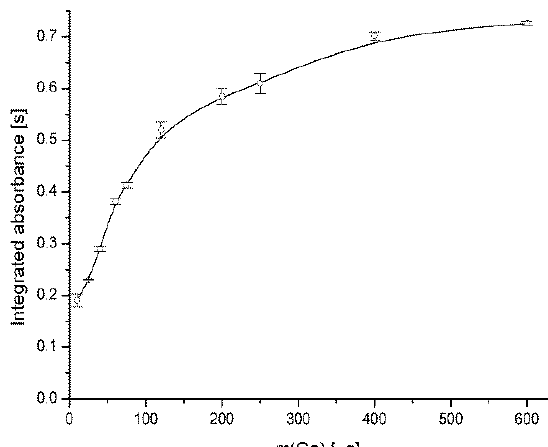
Figure 4. Dependence of GaF molecule absorbance at 211.248 nm on Ga mass added for furnace pretreatment; T pyrol. = 600 °C; T vapor. = 1540 °C; m (Pd) = 7.5 μ g; m (Zr) = 0.15 μ g; m (Ru) = 1.0 μ g; m (Ga sol. ) = 20 μ g; m (CH 3 COONa) = 5.0 μ